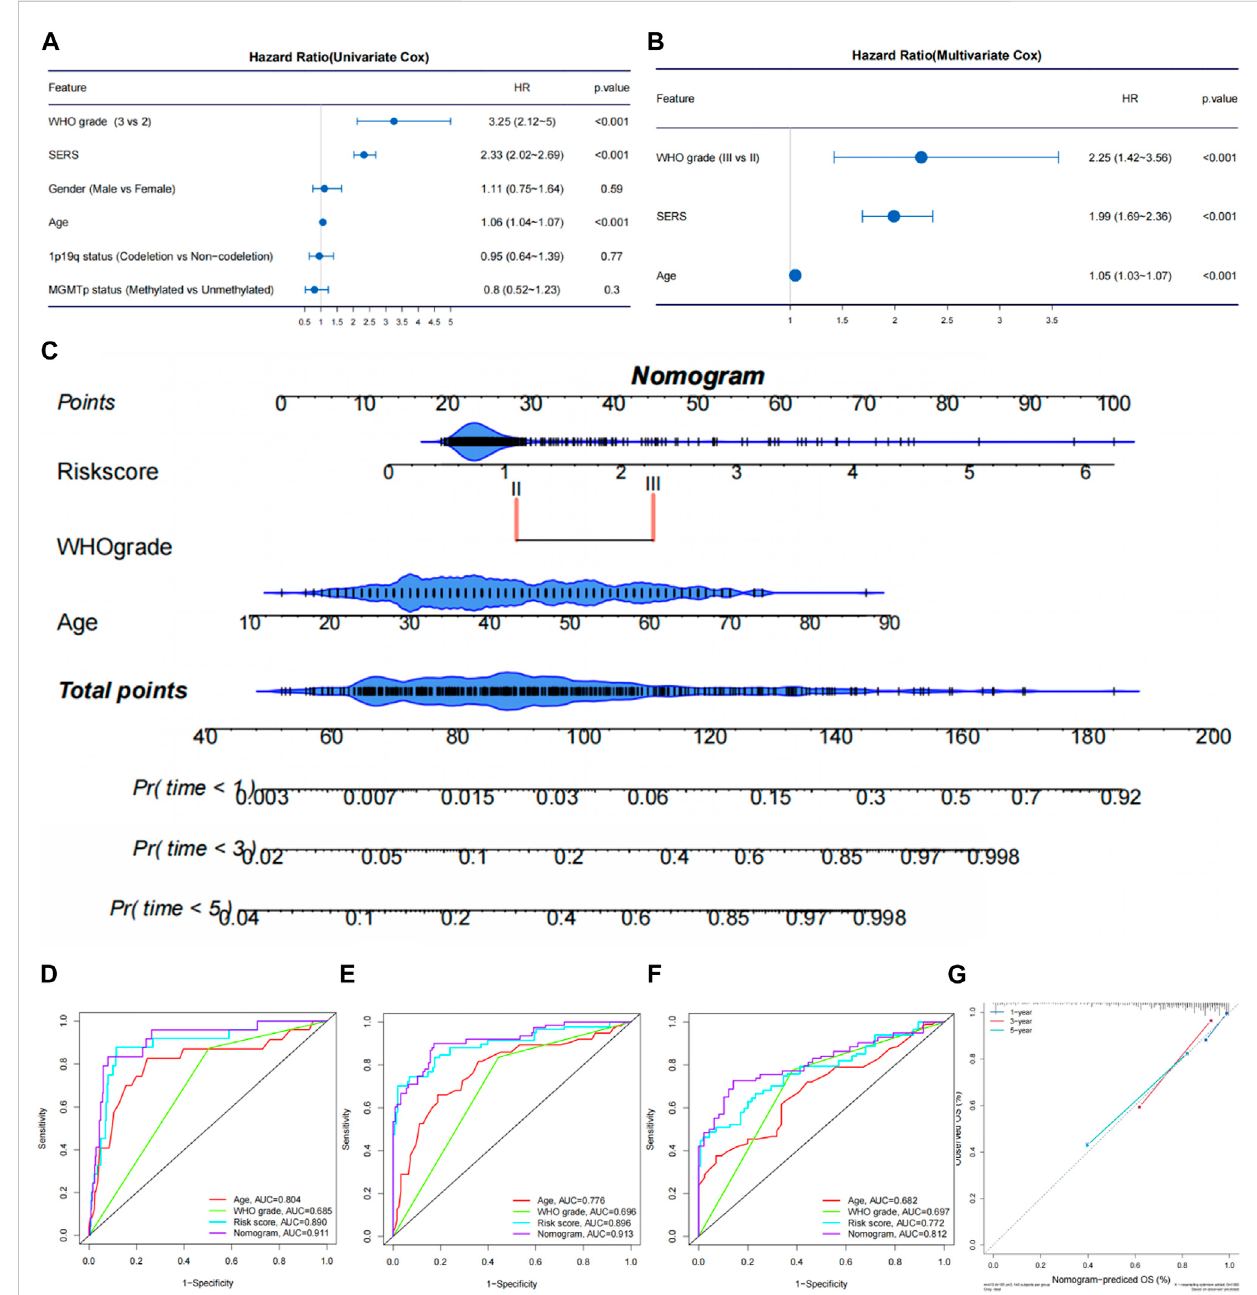
FIGURE 6 Establishment and evaluation of a nomogram in the TCGA cohort. (A, B) The univariate Cox regression and multivariate Cox regression were performed on SERS and other clinicopathological features TCGA cohort. (C) Nomogram based on SERS, WHO grade and age. (D – F) The